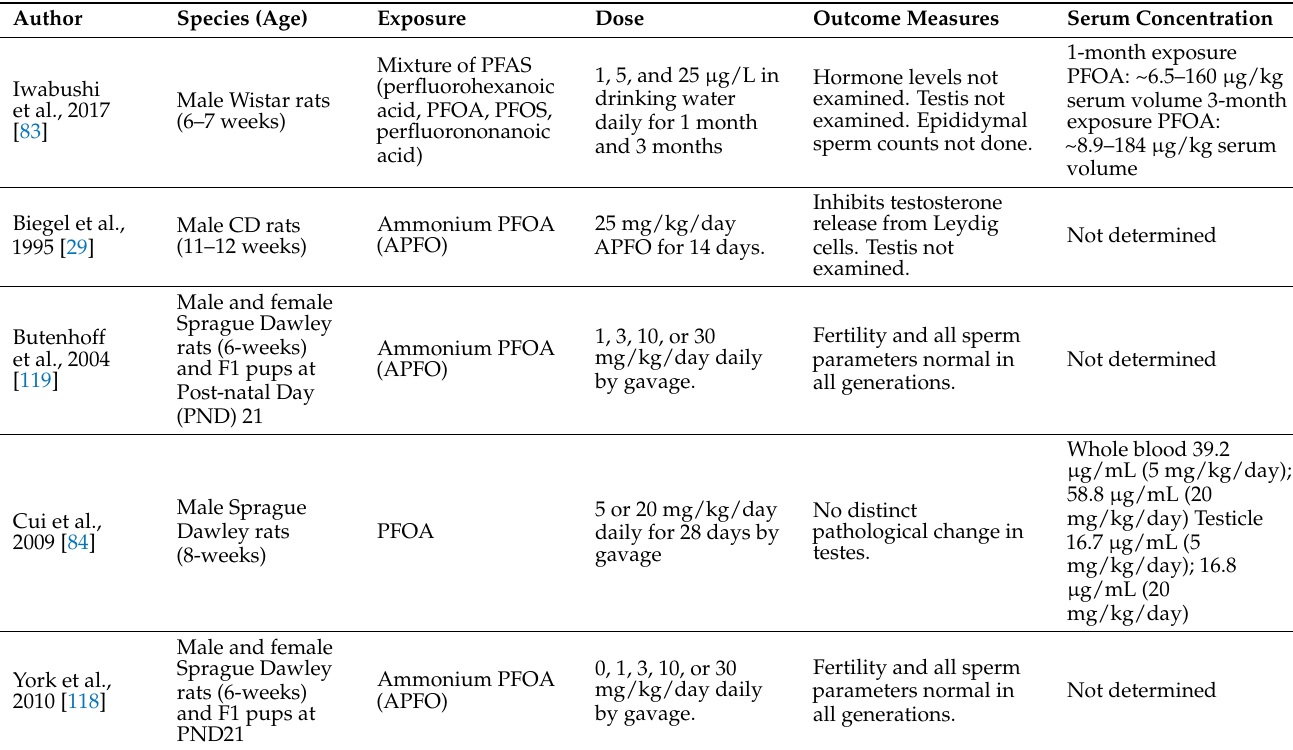
Table 1. PFOA exposure and male fertility measures in